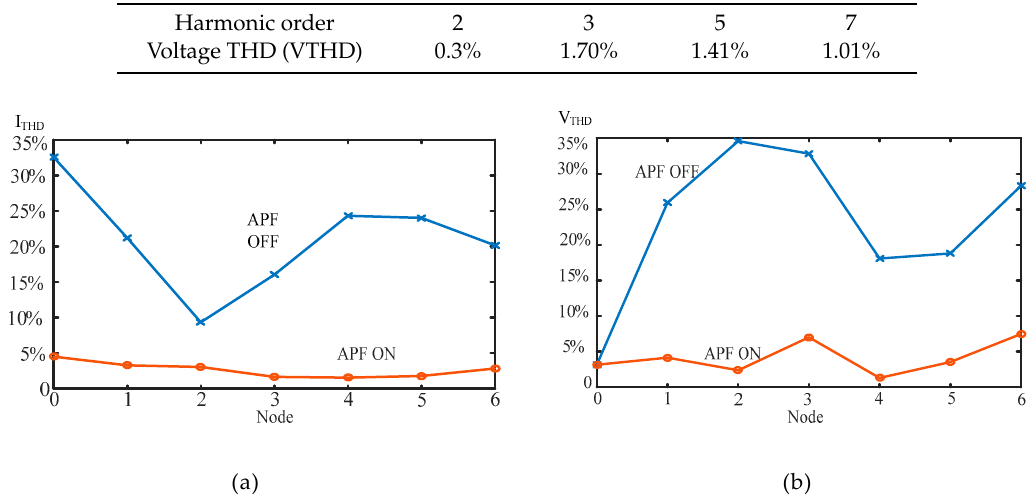
Table 3. Harmonic components of the nonlinear load.